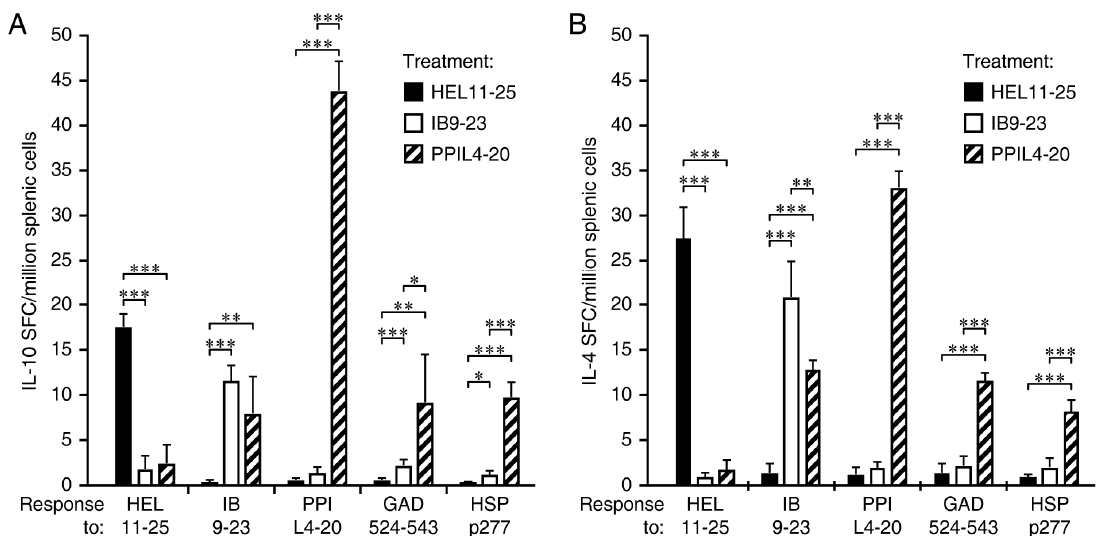
Figure 3. Immunization with PPI L4-20 induces robust IL-10 and IL-4 responses that spread to other ß-cell antigens in NOD mice. Female NOD mice at 15–16 weeks of age were immunized with HEL 11-25 (black bars), insulin B 9-23 (open bars), or PPI L4-20 (hatched bars) in alum IP on day 0 and 10, and ten days later (at about 18–19 weeks in age), their splenic mononuclear cells were tested for ( A ) IL-10 and ( B ) IL-4 responses to the antigens indicated on the X-axis by EPLISPOT assays. Data are expressed as the mean ± SD of SFC in each group ( n = 5) from two separate experiments. The number of SFC in the control cells without antigen stimulation was ≤ 3, while the number of SFC in the positive controls with anti-CD3 stimulation was about 235. * p < 0.05, ** p < 0.01, and *** p < 0.001 by Student’s t -test. The frequency of naïve T cells reactive to these antigens in unvaccinated mice, as determined by tetramer staining, is shown in Figure 2.